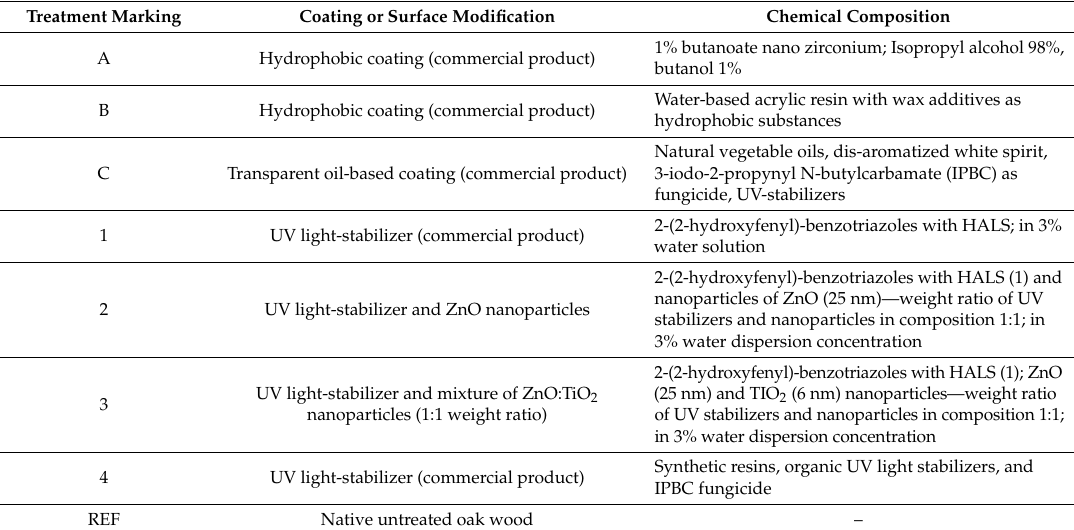
Table 1. Oak wood modifications and chemical composition of the applied treatments. Treatment Marking